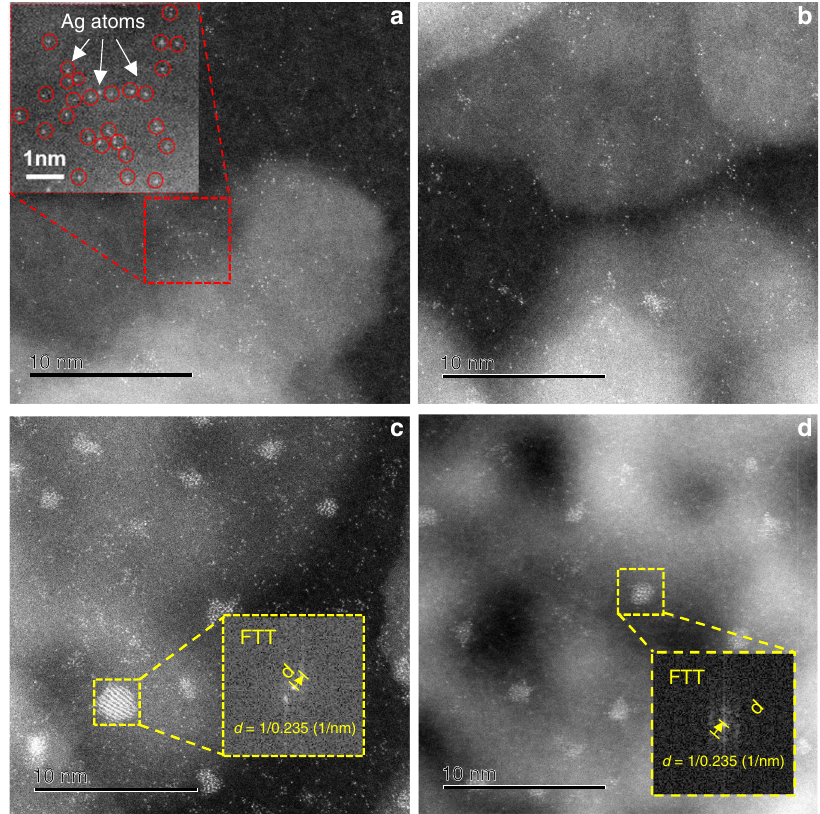
Fig. 1 HAADF-STEM images of Ag/ γ -Al 2 O 3 samples. a 1% Ag/nano-Al 2 O 3 , b 2% Ag/nano-Al 2 O 3 , c 4% Ag/nano-Al 2 O 3 and d 1% Ag/micro-Al 2 O 3